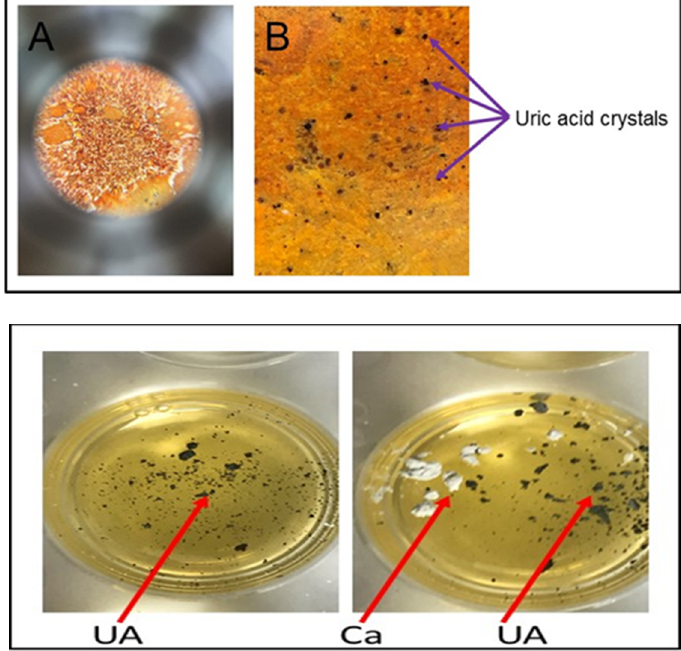
Figure 3. Reduction of silver nitrate pre-coated stains of increasing concentrations by crystallized urate. Varying concentrations of silver nitrate solution were added to wells and allowed to dry overnight, before being removed by pipet. Amorphous uric acid powder (1 mg / 200 µ L) in suspension was added to each of the wells; 20% silver nitrate showed most e ff ective staining.